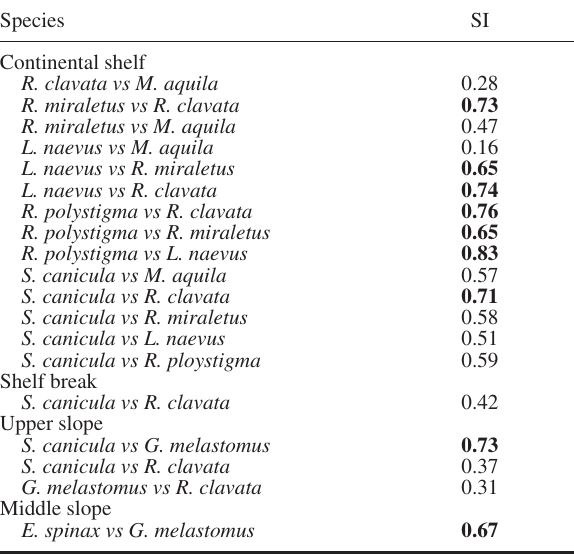
Table 2. – Diet overlap (Schoener index, SI) for coexisting elas- mobranch species on the continental shelf, shelf break, upper and middle slope of the western Mediterranean. Biologically significant diet overlaps (SI > 0.6) are in bold.